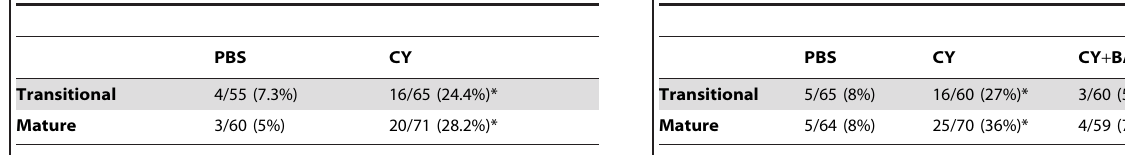
Table 5. Frequency of high affinity DNA-reactive B cells in CY- treated R4A Tg mice.